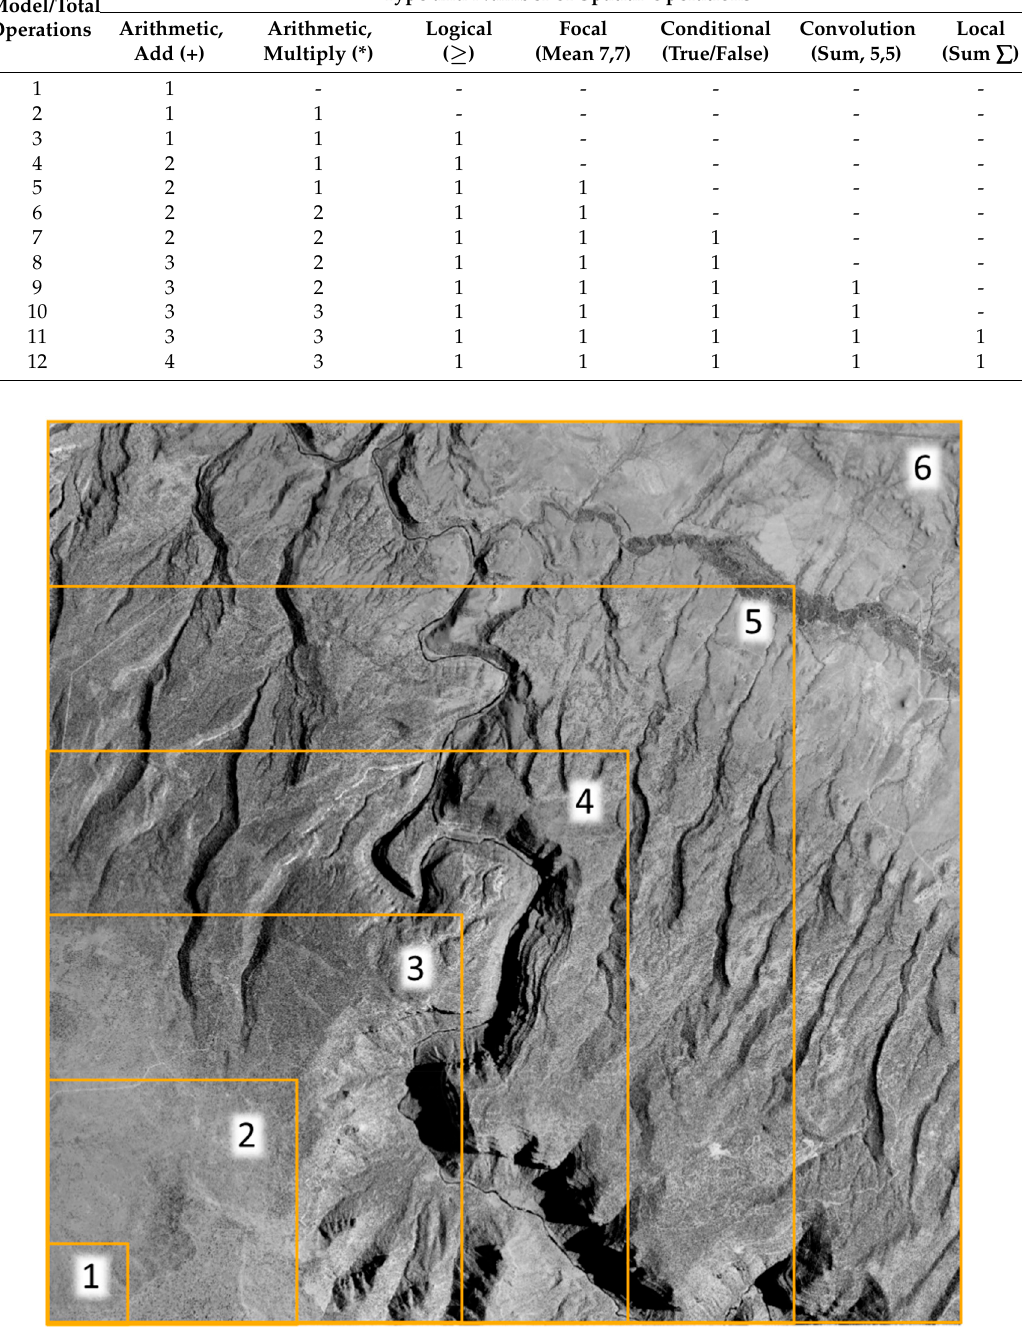
Figure 4. Extent, size, and layout of each image within simulations.